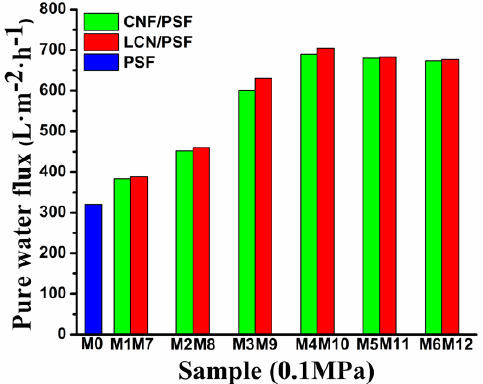
Figure 13. Pure water flux of membranes.